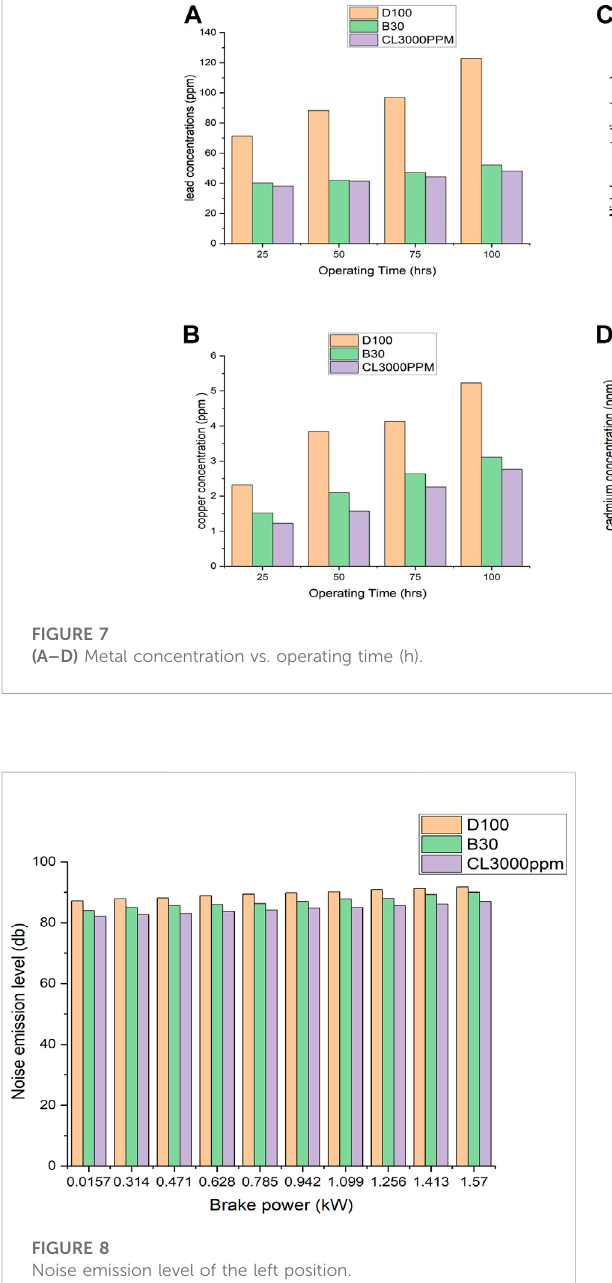
cylinder linear shafts, and other CI engine components as the most common (Cd) source of wear in lubrication oil. The results are greater in diesel fuel than in B100 and clove oil additives. The average percentage of metal concentration is lower than diesel than that in biodiesel-blended fuel and biodiesel blended with clove oil. It has observed that reduction may occur using biodiesel and clove oil-blended fuel sample. Developed reduction in cylinder the internal